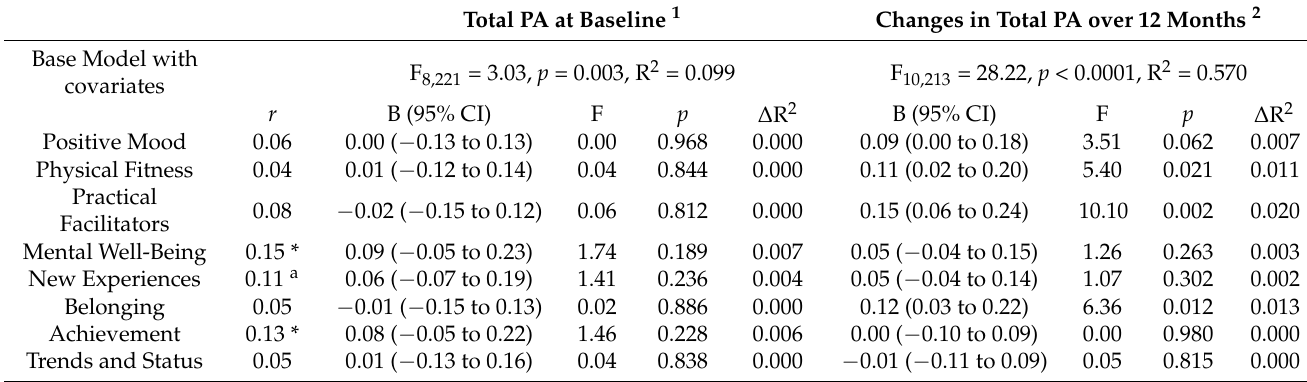
Table 5. The associations between physical activity meaning dimensions and accelerometer-measured total physical activity (Total PA) over 12 months (Pearson correlation coefficients for correlations at baseline ( r ) and covariate adjusted general linear models (B, 95% CI, F, p ) with change in R 2 with reference to the base model with covariates ( ∆ R 2